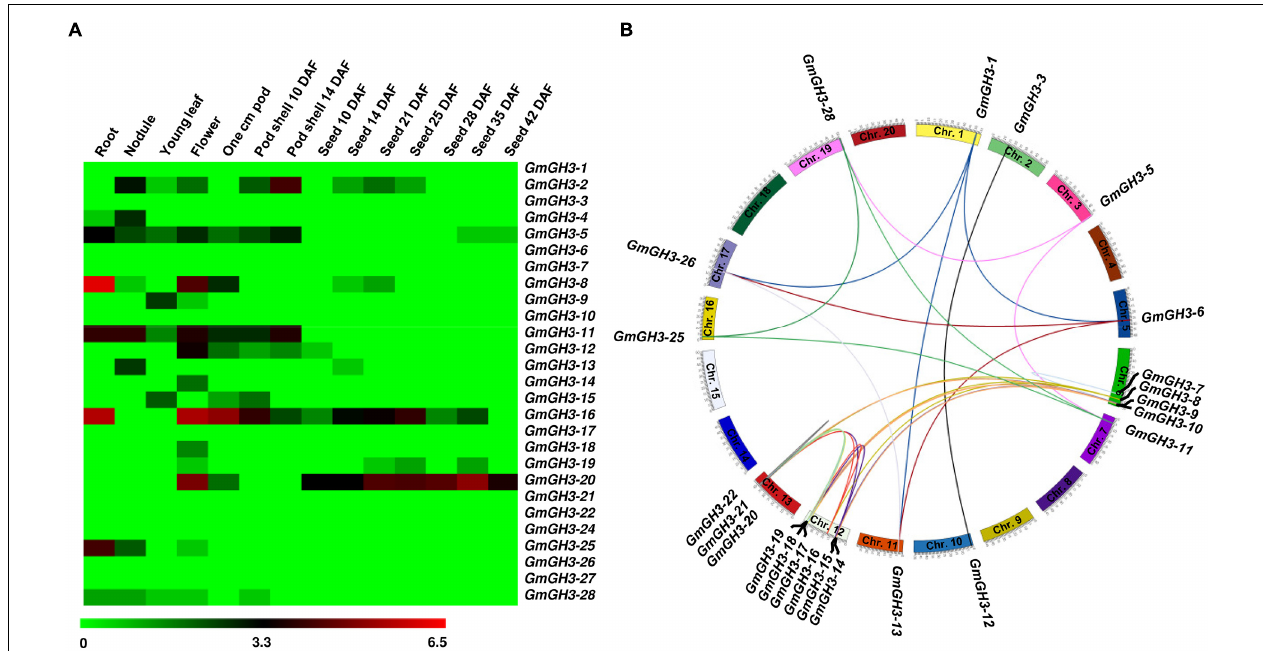
FIGURE 4 | Expression profiles and gene duplication of GmGH3 genes. (A) Heatmap showing expression profiles of soybean GH3 genes at various stages of development. Heatmap was generated based on log 2 RPKM. (B) Mapping of GmGH3 genes and duplication between them are shown on